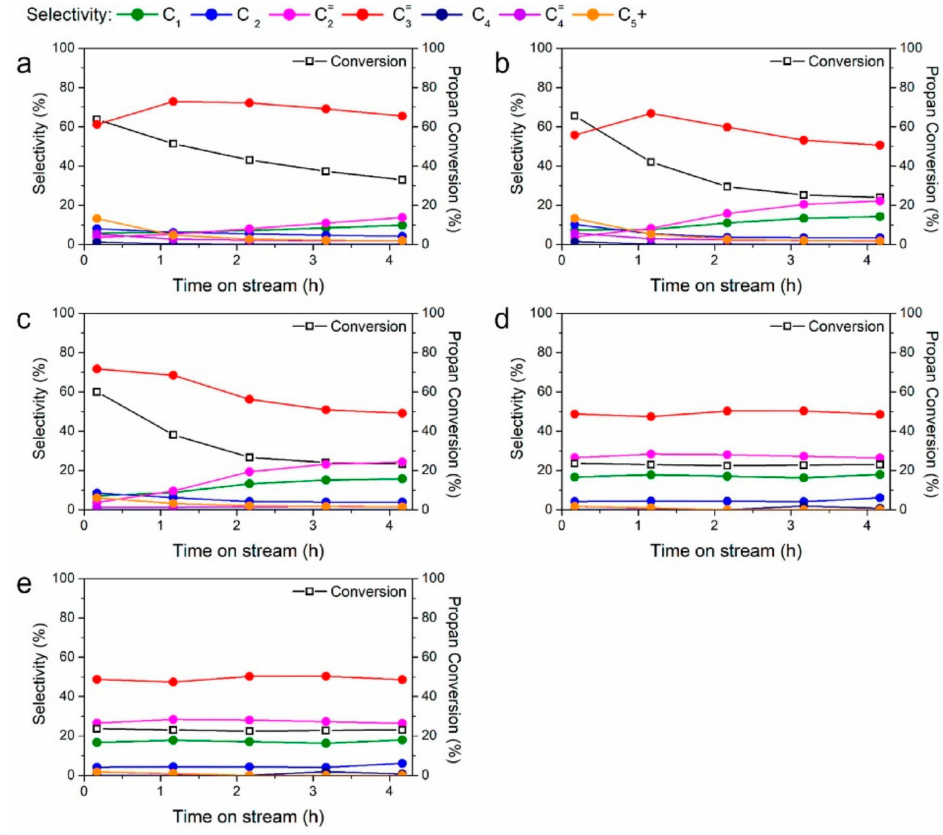
Figure 8. Catalytic performance of PDH over supported Pt-Sn catalysts at 620 ◦ C: ( a ) Pt-Sn/Beta(300), ( b ) Pt-Sn/Beta(38), ( c ) Pt-Sn/ θ -Al 2 O 3 , ( d ) Pt-Sn/Q6, and ( e ) blank test in the absence of catalysts.